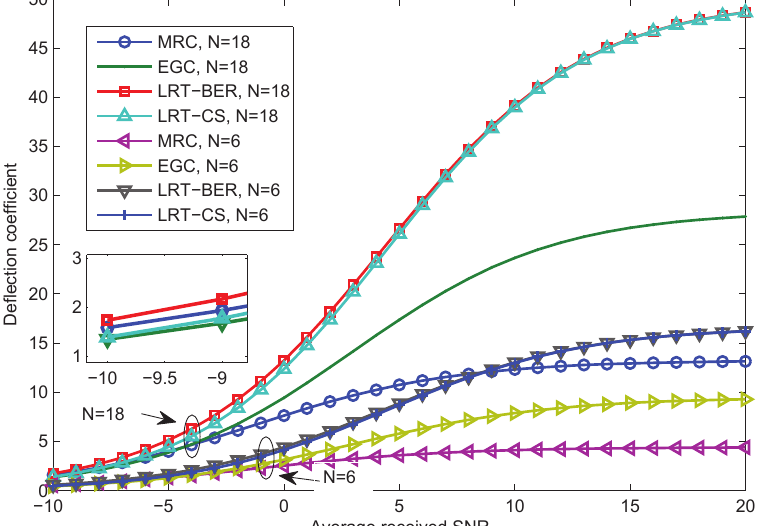
Figure 7. Deflection coefficient of MRC, EGC, LRT-CS, two-stage CV and LRT-BER statistics with six and eighteen sensors, respectively, P and the Rayleigh fading assumption are